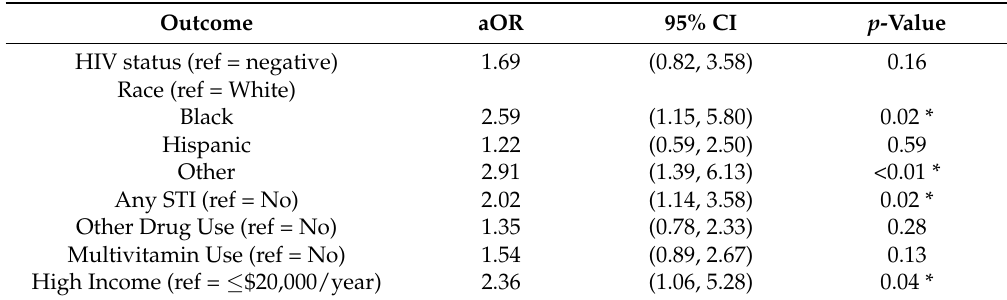
Table 3. Multivariable logistic regression for opinion leadership